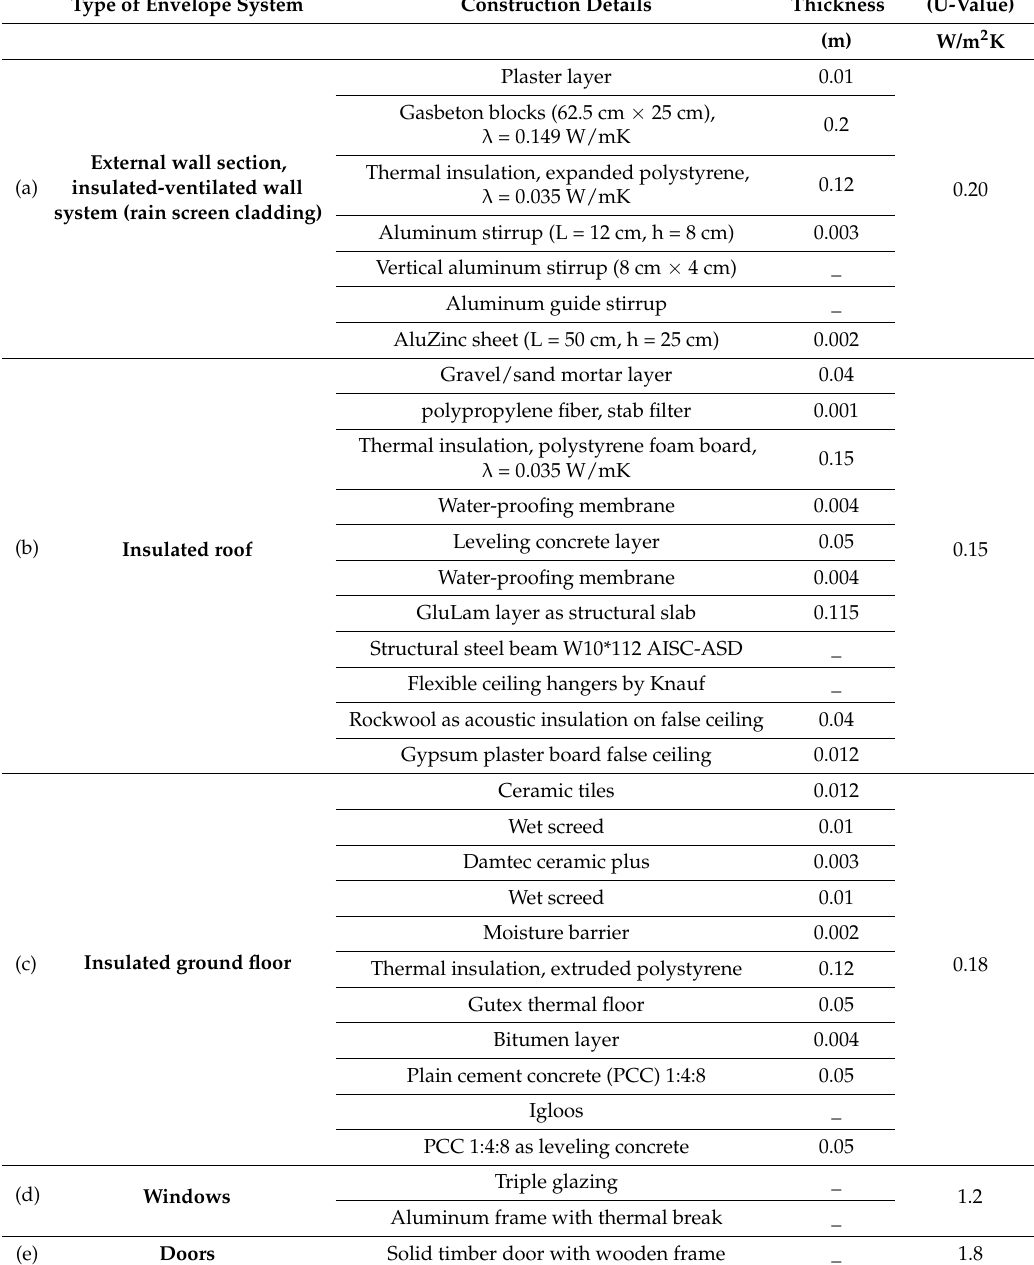
Table 3. Summary of proposed sections (external wall, roof, ground floor, windows and